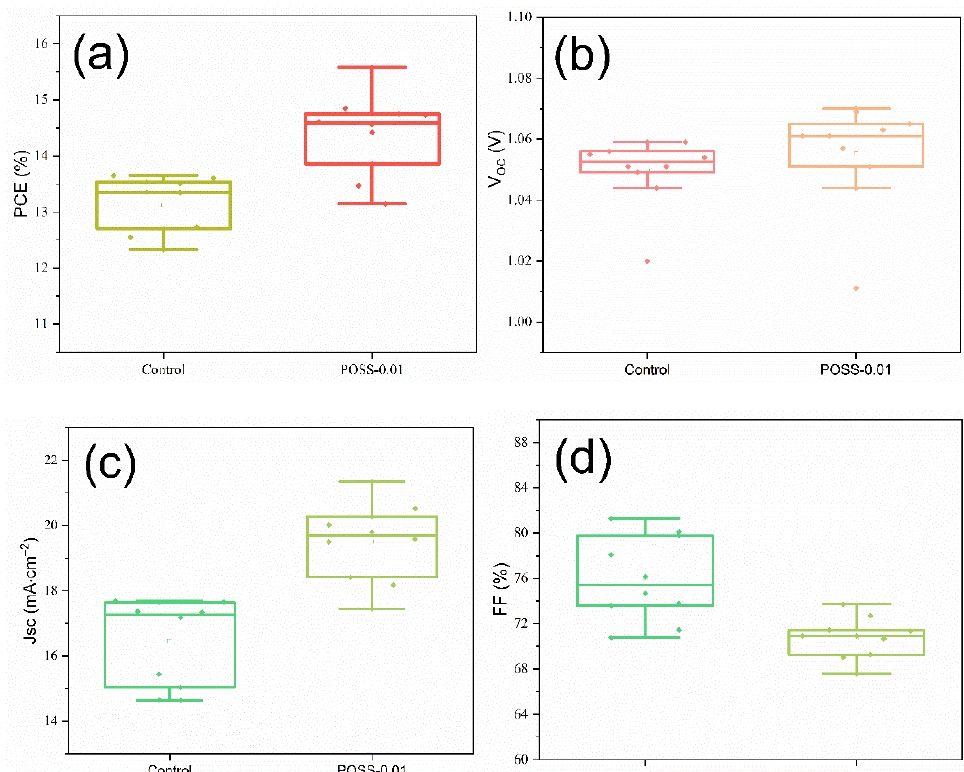
Figure 7. Distribution of device metrics for 10 cells fabricated without and with POSS passivation layer: ( a ) PCE; ( b ) V OC ; ( c ) J SC ; and ( d ) FF. Table 1. The photovoltaic characteristics of the control cell and the PSC fabricated with various POSS contents.